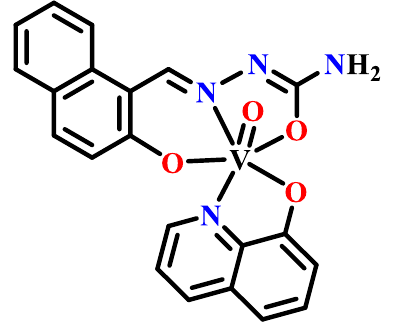
Figure 63. A new oxovanadium(V) complex of naphthylhydrazone with a urea side chain and 8-hydroxyquinoline (8-HQ) as a co-ligand.